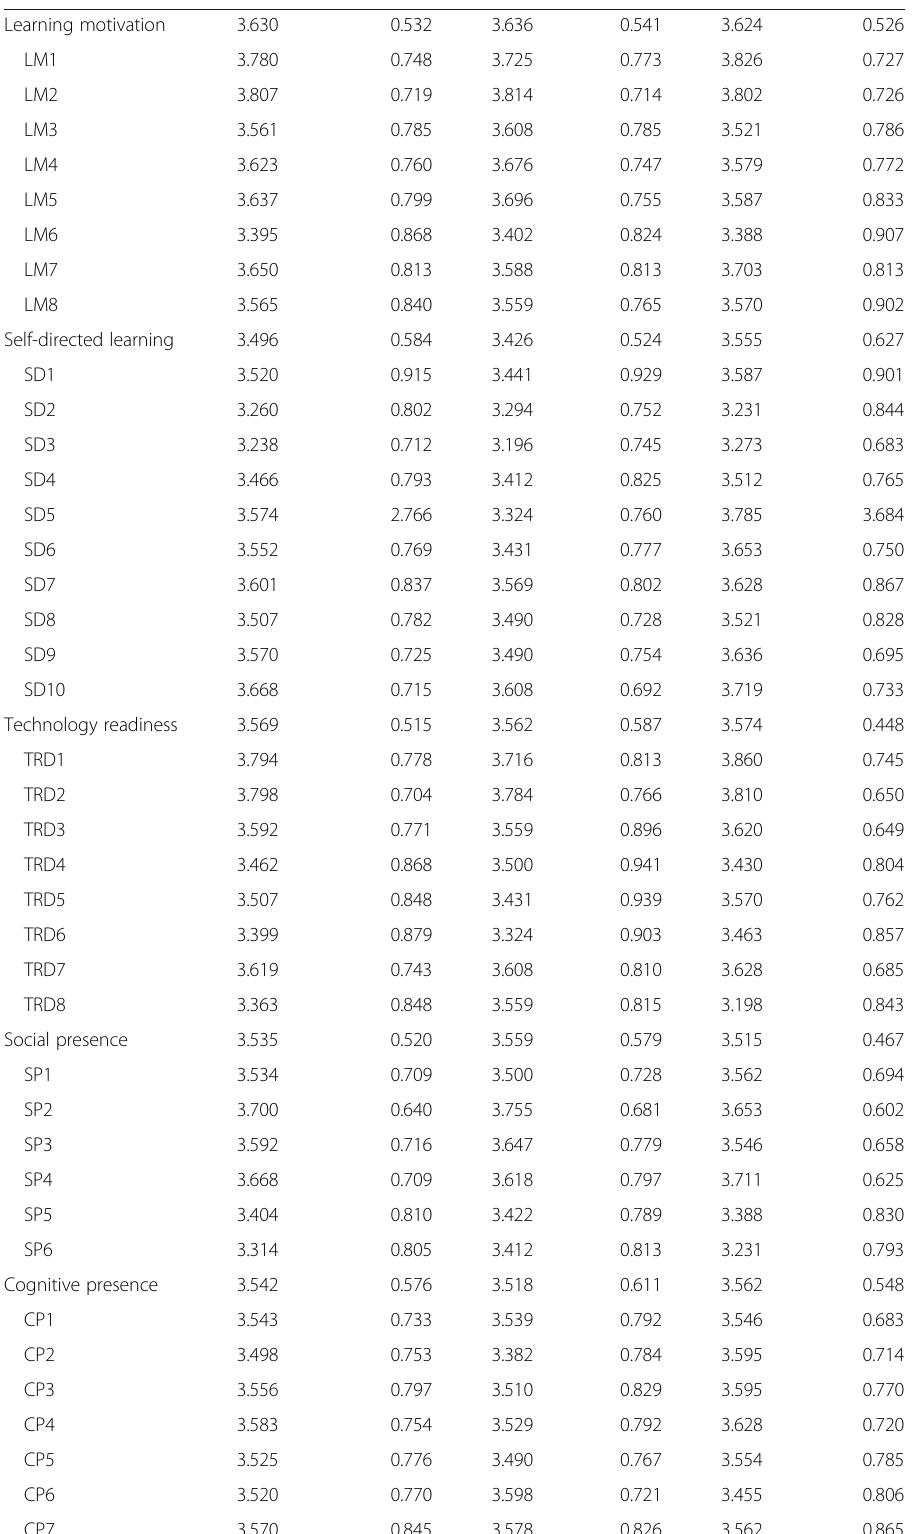
Table 5 Overall statistical